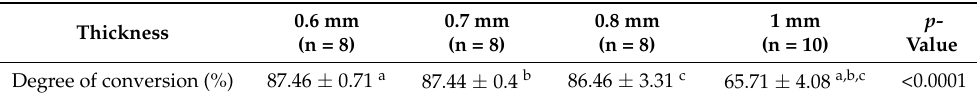
Table 4. Mean values ( ± SD) for the degree of conversion (DC) depending on the ceramic’s thickness. All the veneers have been designed with a MT-A2 opacity. a , b and c indicate a p -value < 0.001 between the two concerned